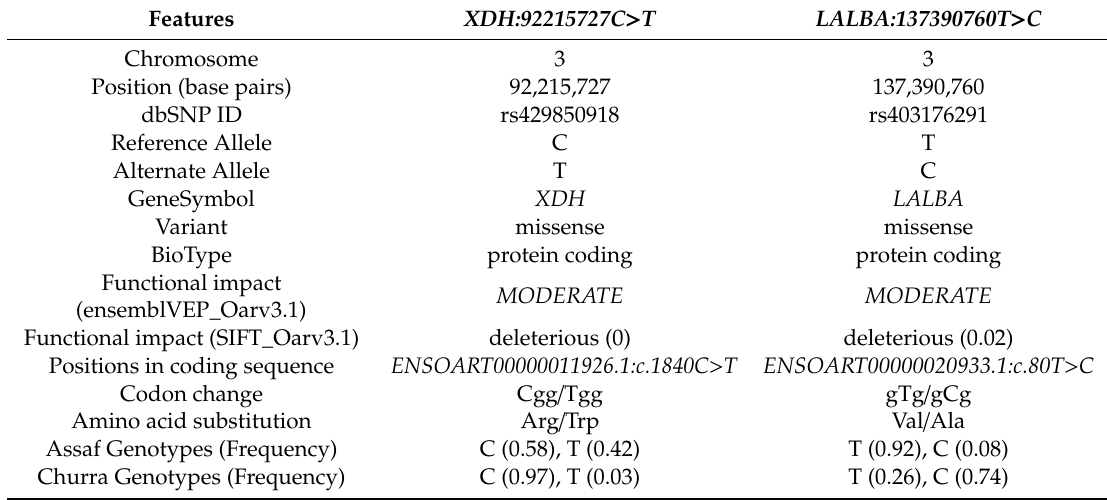
Table 2. Characterization of the two potential functionally relevant variants identified in the candidate genes considered in this study showing allele frequency divergence between Churra and Assaf